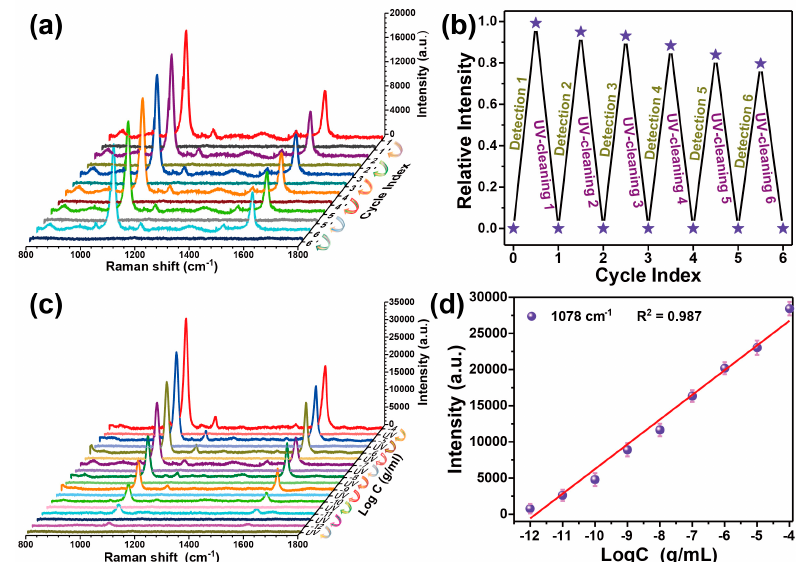
Figure 9. ( a ) SERS spectra recorded during recyclable immune detection of PSA at the concentration of 10 − 7 g / mL; ( b ) The corresponding variation of the relative SERS intensity at 1078 cm − 1 ; ( c ) Recycle immunoassays of PSA at di ff erent concentrations based on SERS spectra; ( d ) The corresponding variation of the SERS intensity at 1078 cm − 1 .